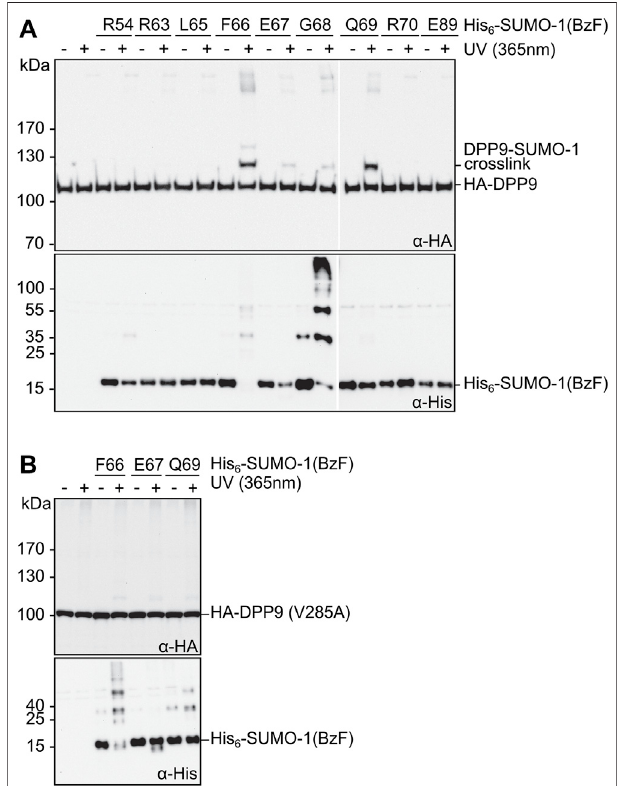
FIGURE 3 | Photo-crosslinking of SUMO-1 probes in mammalian cell extract. (A) and (B) SUMO-1 probes with BzF at different positions were incubated with HEK293T cell extract of cells transiently transfected with HA- DPP9 and HA-DPP9 (V285A), respectively. Samples taken before and after the UV-irradiation were analyzed by western blotting. The SDS gels used for the immunoblotting in the top panels contained 8% polyacrylamide, whereasthoseinthebottompanels(intendedasloadingcontrolsforSUMO-1 probes) were prepared with 17.5% polyacrylamide and hence had limited ability to transfer high molecular weight proteins.